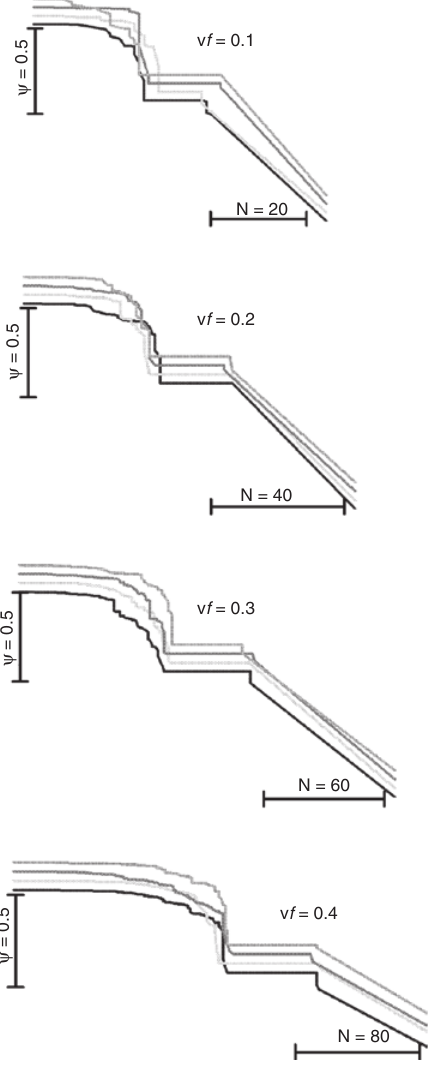
Figure 8: Scale plot of generated clusters count (N) vs. inconsist- ency coefficient ( Ψ ) for (A) vf = 0.1, (B) vf = 0.2, (C) vf = 0.3 and (D) vf = 0.4. (Curves are nudged by 0.05 unit along Y axis to prevent the overlap).